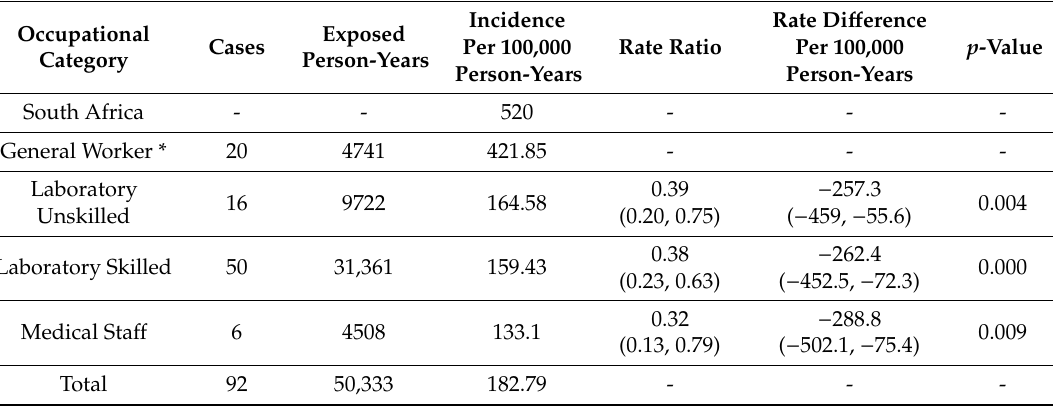
Table 2. TB Incidence Rates by Occupational